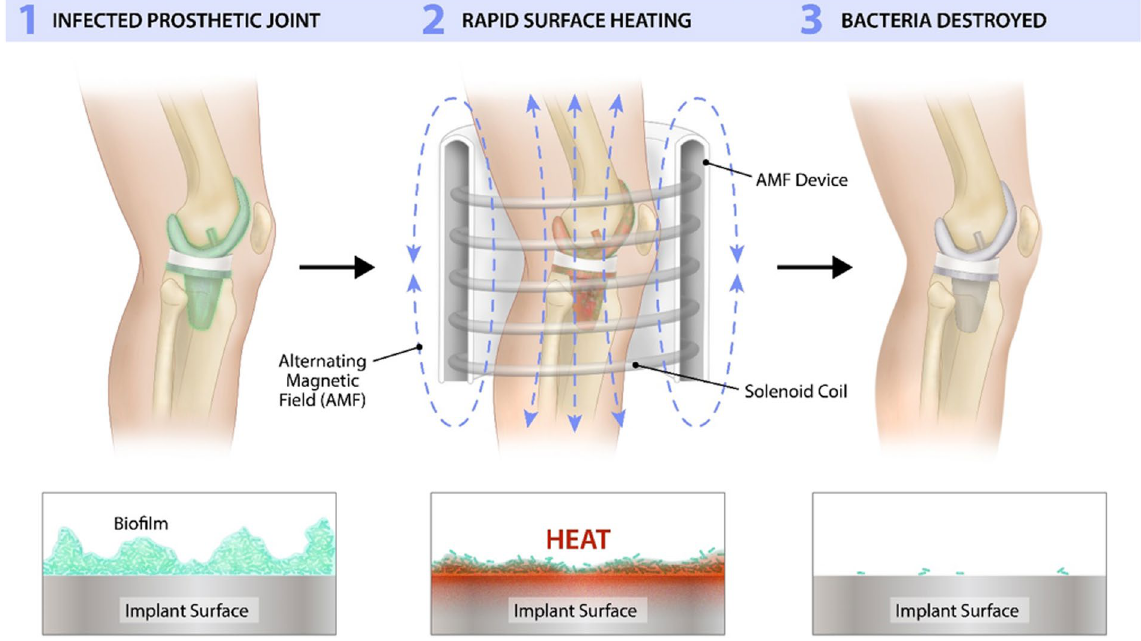
Figure 1. Targeting biofilms located on the surface of metallic implants with high-frequency alternating magnetic fields (AMF). (1) The presence of biofilm on an infected prosthetic usually necessitates surgical replacement as a curative treatment due to an increased resistance of these bacteria to antibiotics. (2) Rapid and non-invasive surface heating of a metallic implant can be achieved using a high-frequency ( > 100 kHz) alternating magnetic field (AMF). (3) Cytotoxic levels of heating can be generated by the AMF exposures as a means to destroy bacteria and removes extracellular polymeric substances (EPS) associated with the